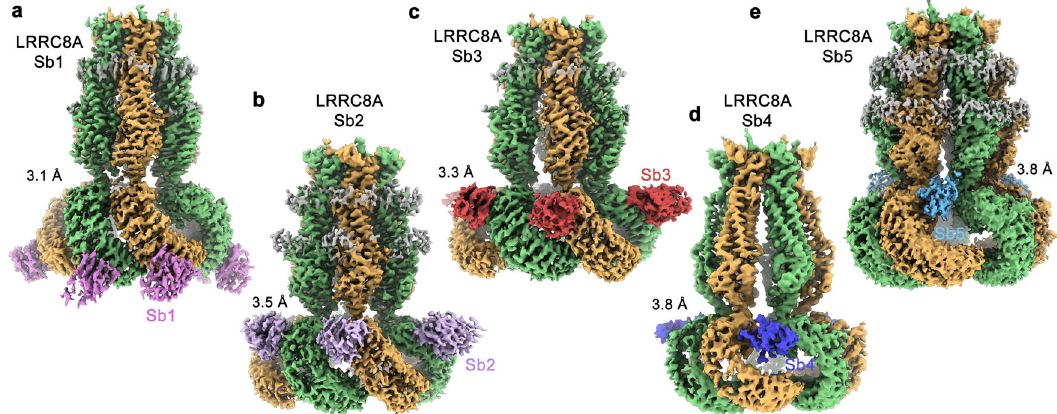
Fig. 3 Cryo-EM density of LRRC8A-sybody complexes. a LRRC8A/Sb1 complex at 3.1 Å. b LRRC8A/Sb2 complex at 3.5 Å. c LRRC8A/Sb3 complex at 3.3 Å. d LRRC8A/Sb4 complex at 3.8 Å. e LRRC8A/Sb3 complex at 3.8 Å. a – e Subunits at left and right positions in the C3-symmetric channels are colored in green and beige, respectively. Sybodies are shown in unique colors, residual density of the detergent micelle in gray. Binding of sybodies to all six subunits in case of the complexes with Sb1, Sb2 and Sb3, and to the subunits at r-positions in case of complexes with Sb4 and Sb5